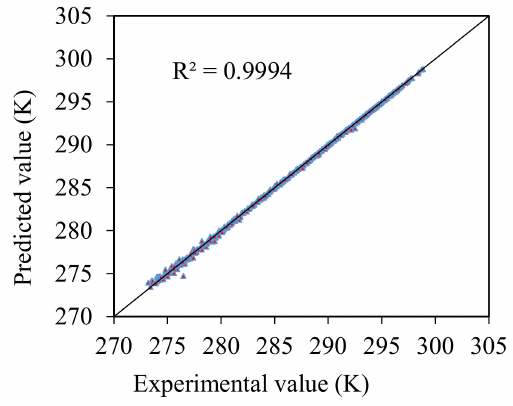
Figure 2. Training results for the GA-SVM model.